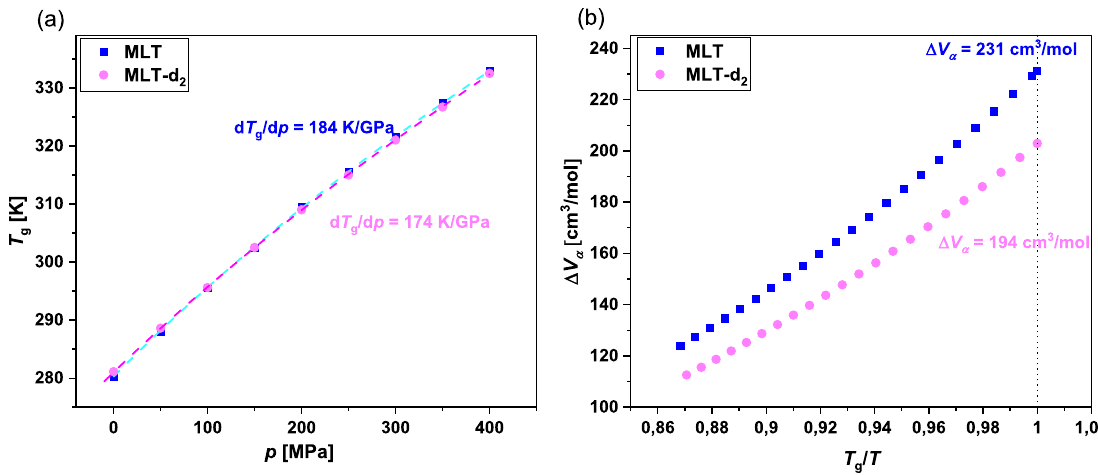
Figure 8. T g plotted as a function of p for MLT and MLT-d 2 ( a ). The solid lines present the fits using Eq. 5. Dependence of the activation volume for the α -process (Δ V α ) versus T g / T for both substances ( b